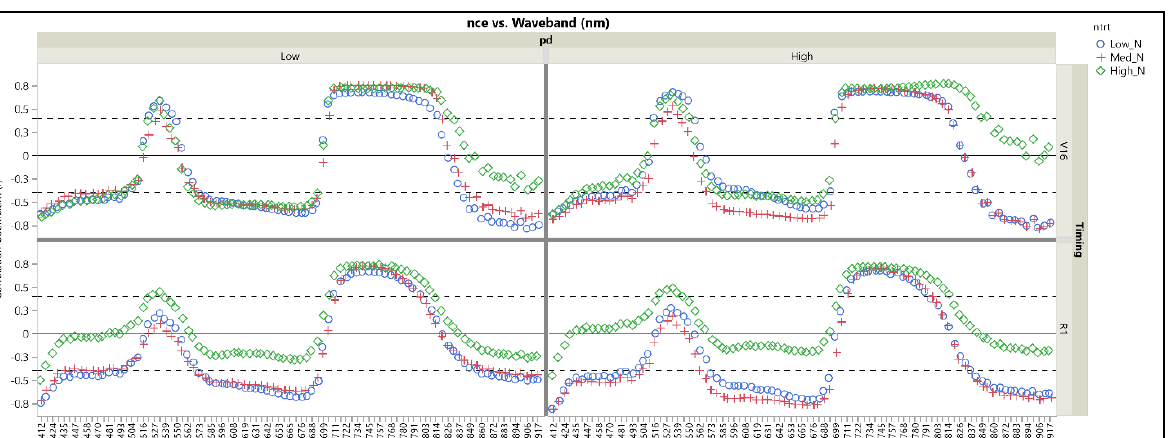
Figure 2. Pearson product-moment correlations (r) for N concentration (pN) at R6 by waveband (nm) from images at V16 (upper block) or R1 (lower block) for low and high planting density (pd) colored by N treatment (Low N = blue circle, Med N = red plus, High N = green diamond). Black lines are for reference only: solid line is at r = 0 and dashed lines at r = |0.4|.